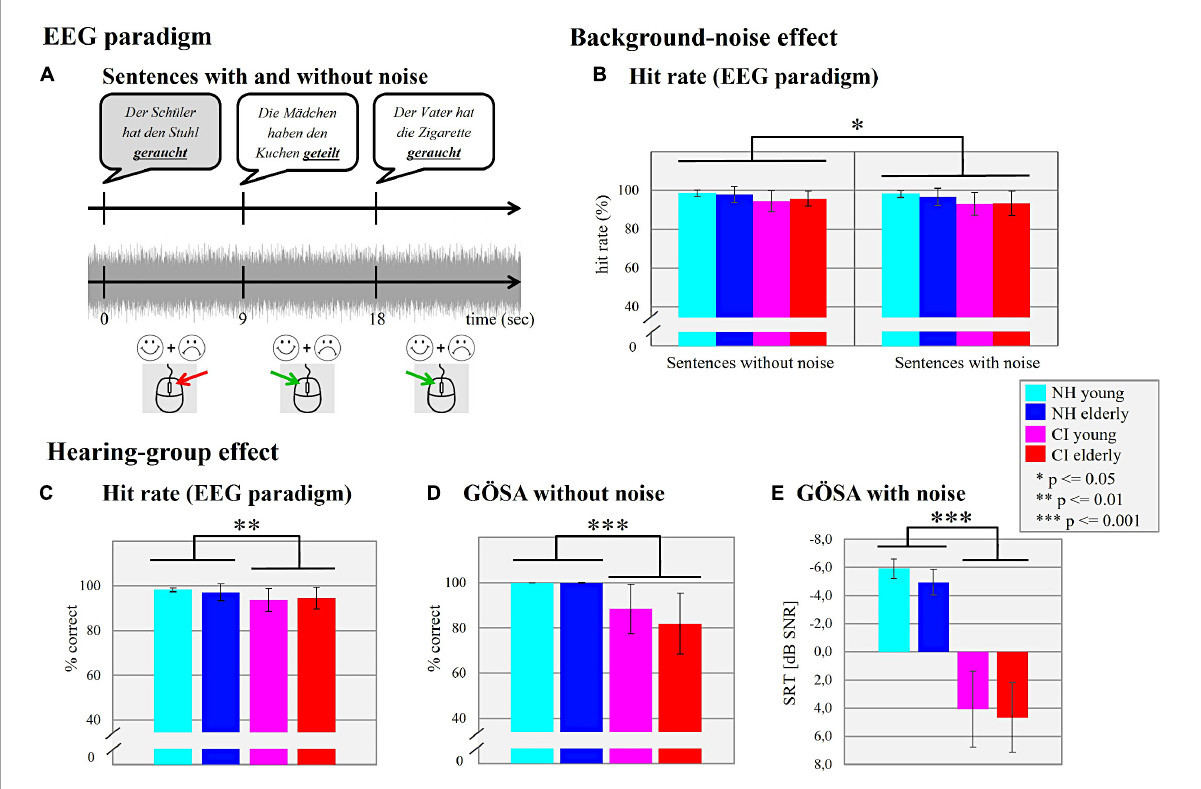
FIGURE1 Electroencephalography (EEG) paradigm. (A) Sentences with and without noise. Schematic illustration of the sentence paradigm used in the actual study. By pressing a relevant mouse button, the participants were asked to distinguish between semantically correct (white) and semantically incorrect (gray; i.e., violated) sentences. Background-noise effect. (B) Hit rate (EEG paradigm). The mean hit performance (%) of the four different subgroups (NH young, NH elderly, CI young, CI elderly) in the situation without and with background noise is shown. Hearing-group effect. (C) Hit rate (EEG paradigm). The mean hit perfo rmance (%) for the four different subgroups is shown independently of the background noise. (D) GÖSA without noise. Mean percentage of the correctly identified words (% correct) for each subgroup is shown. (E) GÖSA with noise. Mean SRT (dB SNR) for a 50% speech intelligibility for each subgroup is